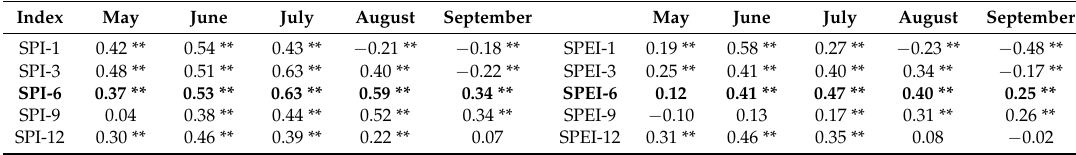
Table 5. Spearman’s rank correlation value of multi-time scale SPI and SPEI with YAI from May to September. Two star superscript (**) indicates p < 0.01. SPI-6 and SPEI-6 were marked in bold to show their superior abilities in representing yield loss anomaly. Sampling size of SPI and SPEI was 433 and 281, respectively.